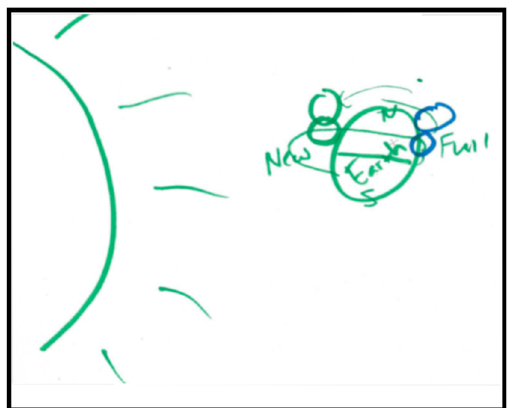
FIG. 8. Faith ’ s Earth-Moon-Sun geometrical configuration for a waxing crescent Moon phase (circles between Sun and Earth) and waxing gibbous Moon phase (small circles near “ Full ” ). She indicated a lunar orbit that circles the equator in a counterclock- wise direction if observed from above the Earth ’ s North